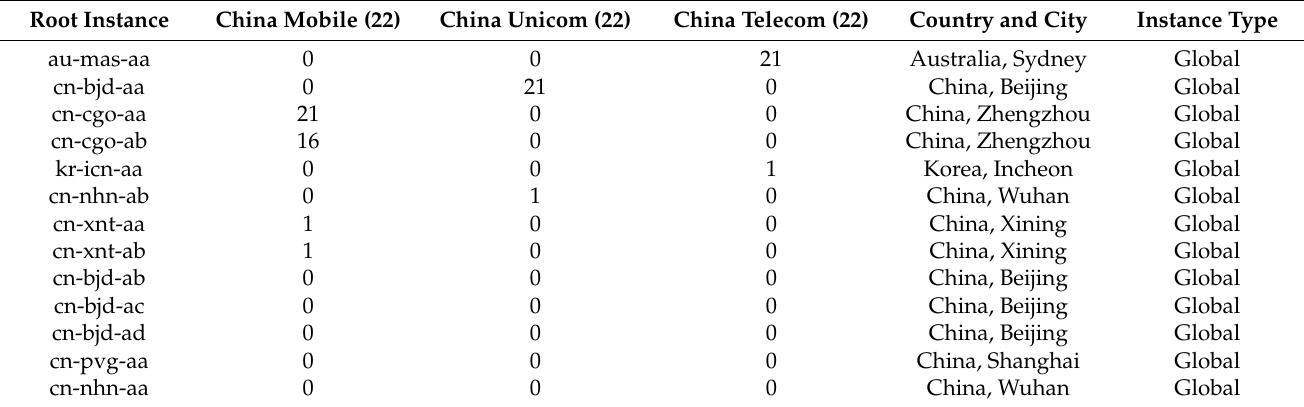
Table 3. Statistics of L root anycast nodes requested by three operators.